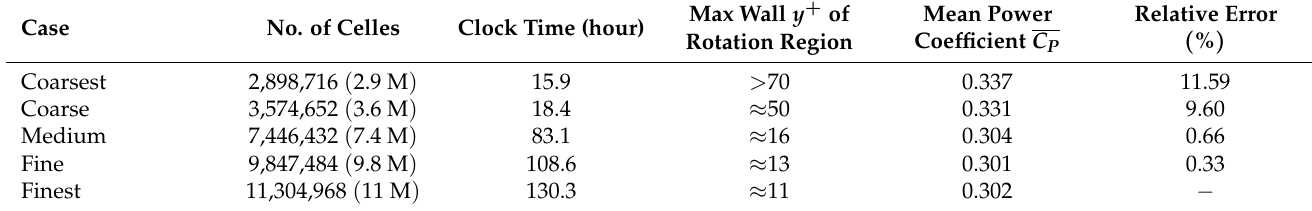
Table 4. Mesh independence verification of computational domain.